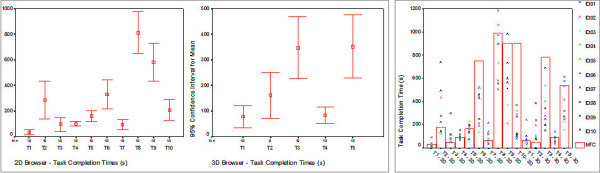
Task completion times for the structured evaluation. The two charts on the left show mean task completion times within a 95% CI, while the third plots task completion times for each task for each user, compared to the expected maximum time (MTC) to complete each task.